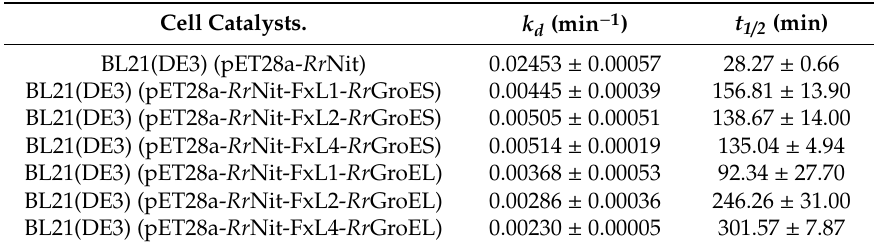
Table 1. Apparent kinetic parameters for thermal inactivation of cell catalysts harboring nitrilase and Rr GroES/ Rr GroEL chimeras at 50 °C.